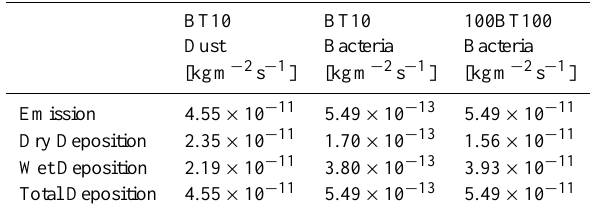
Table 5. Modelled global means of emissions and deposition of bac-